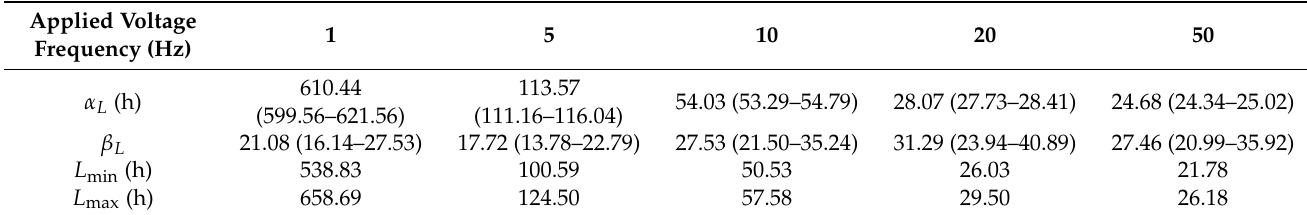
Table 7. Parameters of the Weibull function fitted to the life estimations from results at each applied voltage frequency and their maximum and minimum